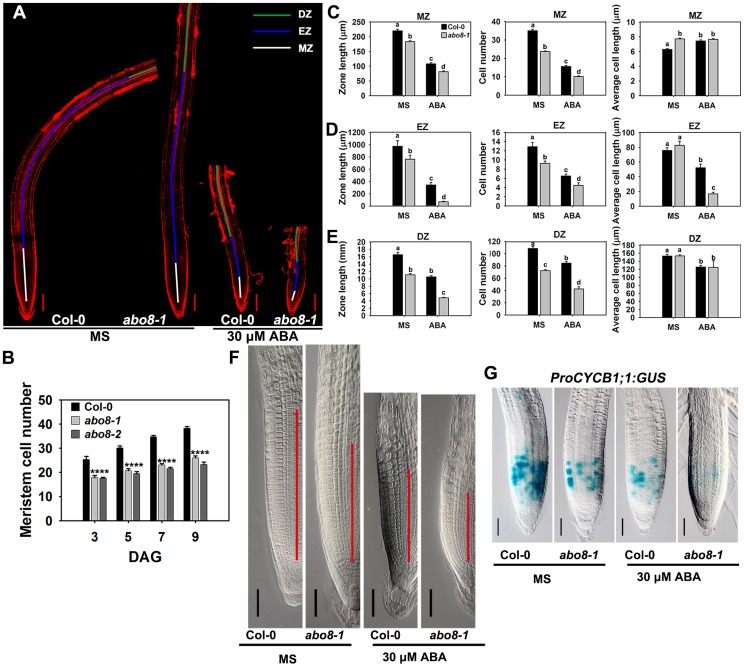

abo8 mutation decreases the activity of the root meristem.A. The meristem zone (white line), elongation zone (blue line), and differentiation zone (green line) with 0 or 30 µM ABA treatment. Bars = 100 µm. Each image was made by joining several photographs of the same root. B. Meristem cell number of the wilt type, abo8-1 and abo8-2 in different times after seed germination (DAG). C. The meristem zone length, cell number, and cell length with 0 or 30 µM ABA treatment. D. The elongation zone length, cell number, and cell length with 0 or 30 µM ABA treatment. E. The differentiation zone length, cell number, and cell length with 0 or 30 µM ABA treatment. In C–E, two experiments were done with similar results, each with three repeats, each repeat with 10 roots. Values are means ±SE from one experiment. Means with different letters are significantly different at P<0.01. F. Size of the amplified root meristem in the wild type and abo8-1 with and without ABA treatment. Bars = 50 µm. G. The expression of ProCYCB1;1:GUS in the wild type and abo8-1 with or without 30 µM ABA treatment. Bars = 50 µm.